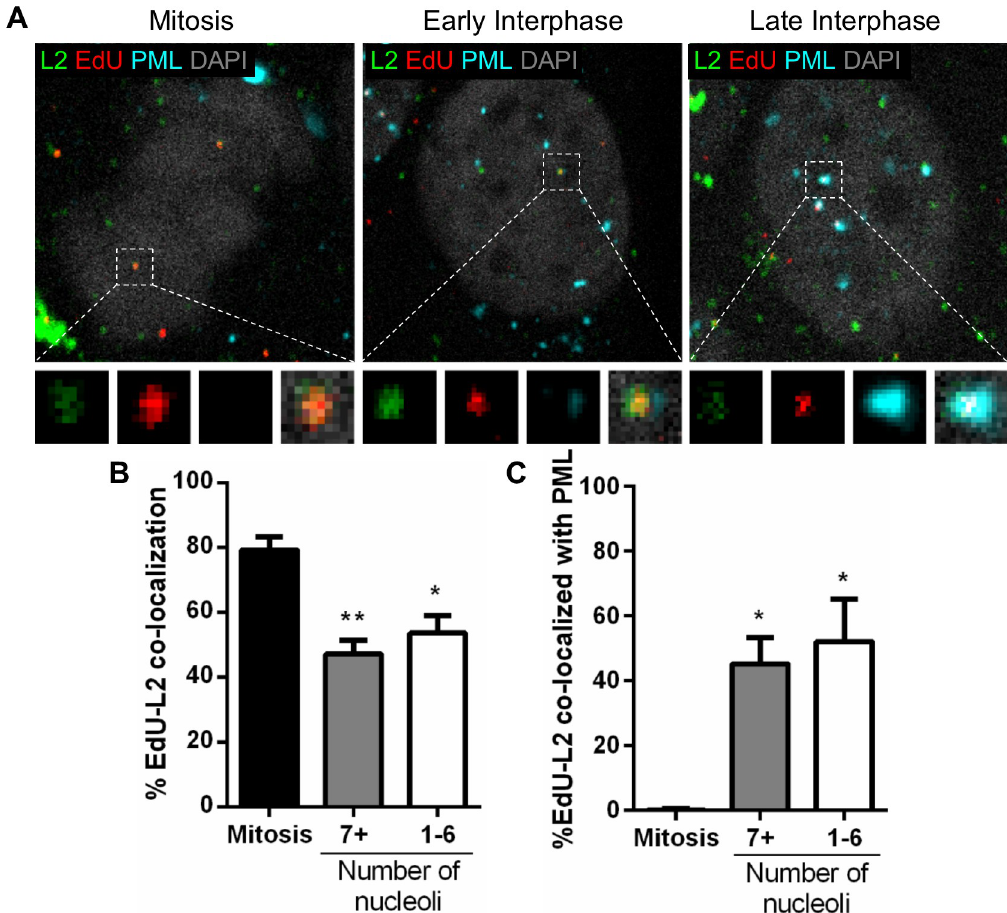
Fig 6. L2 protein remains associated with the viral genome in late interphase. (A) HaCaT cells were infected with EdU- labeled PsVs for 24 h, fixed, permeabilized, and treated with AF555 (red) in Click-iT reaction buffer. Next, the cells were incubated with rabbit anti-PML protein antibody (cyan) and mouse 33L2-1 antibody (green) for specific detection of L2 protein and mounted with DAPI (white). (B) Percent co-localization of EdU and L2 was determined by manually counting the number of EdU puncta and L2 puncta (red/green) over the total number of EdU puncta (red only) associated with condensed chromosomes in mitotic cells or nuclear-localized in interphase cells. Nucleoli were also counted: 7+ nucleoli corresponds to early interphase, 1–6 to late interphase. (C) Percent co-localization of EdU with PML protein was determined by manually counting the number of EdU-L2 puncta (red/green) co-localizing with PML protein signal over the total number of EdU puncta (red only) co-localizing with PML protein associated with condensed chromosomes in mitotic cells or nuclear- localized in interphase cells. Results are shown as average of 3 independent experiments and SEM, with 30–50 cells of each condition (mitotic, early and late interphase cells) collected in z-stacks spanning the whole nucleus. (B) Mitosis: % EdU-L2 = 79.22% ± 4.06%. 7+ nucleoli: %EdU-L2 = 47.11% ± 4.29%. 1–6 nucleoli: %EdU-L2 = 53.59% ± 5.42%. (C) Mitosis: %EdU-L2 at PML = 0.22% ± 0.22%. 7+ nucleoli: %EdU-L2 at PML = 45.20% ± 4.69%. 1–6 nucleoli: %EdU-L2 at PML = 52.11% ± 7.60%. p value was determined using Student’s t -test comparing Interphase to Mitosis. �� : p < 0.01. � : p <